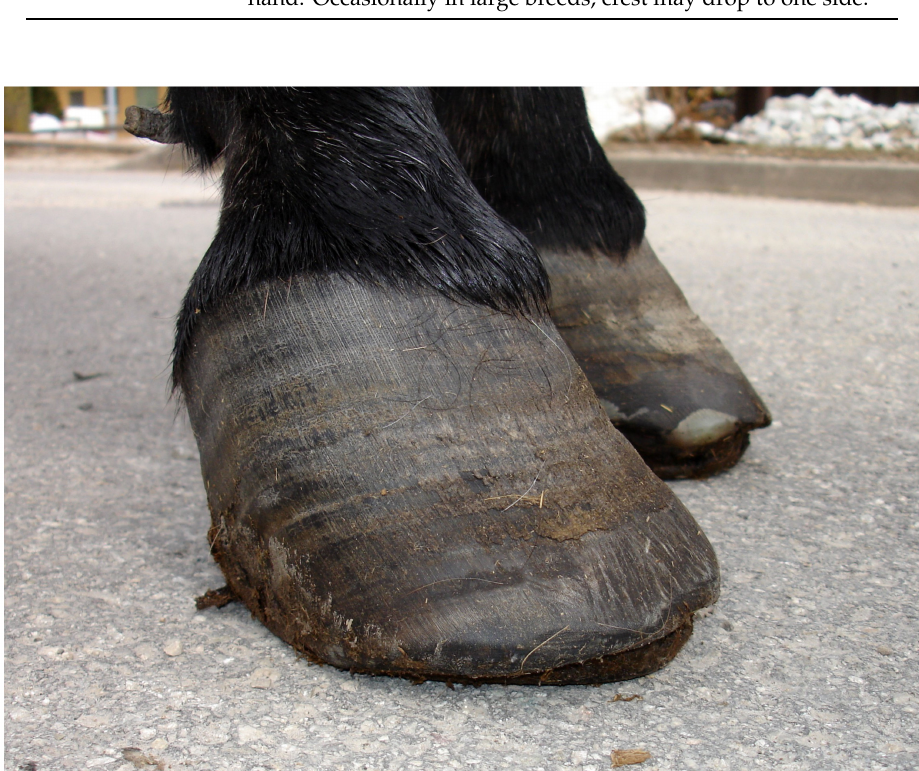
Figure 1. Hooves of a donkey with signs of chronic laminitis. Note the divergent growth